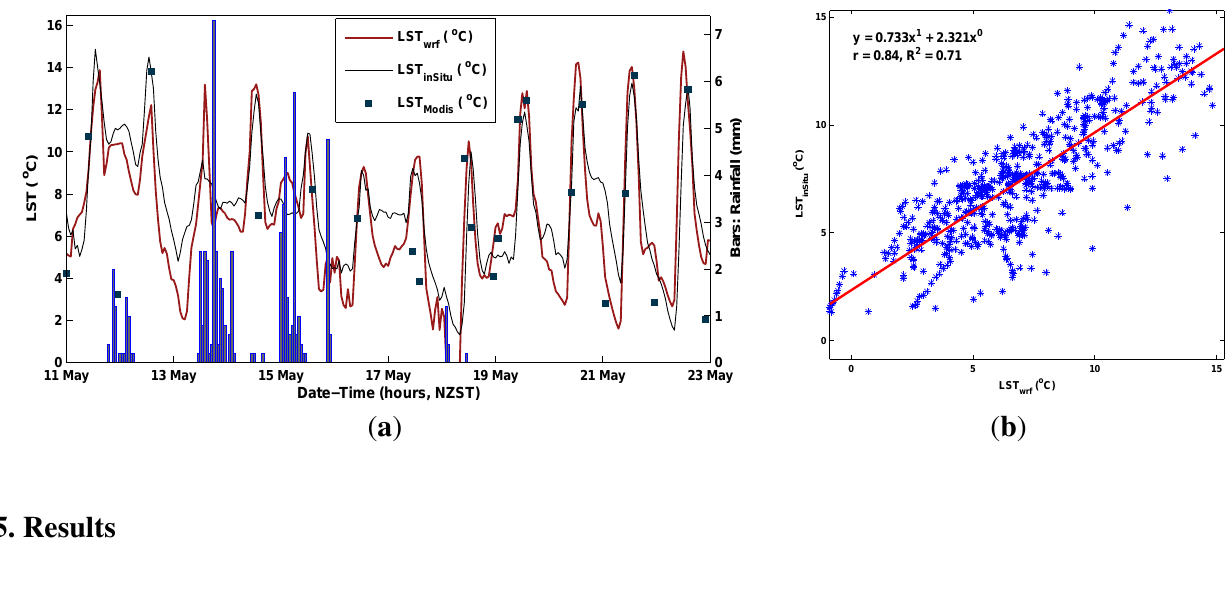
Figure 7. ( a ) Spatially averaged time-series produced from the WRF simulations and the in situ data (both dataset downscaled from 30-minute to hourly rate) overlaid on hourly rainfall (bars) from the UC Cass climate station; MODIS LST is also plotted as dots for those times when data were available; ( b ) The WRF simulations are correlated vs . in situ data (30-minute rate, May